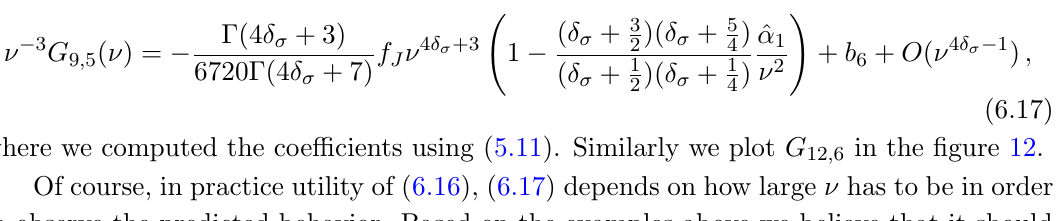
where d is given in (3.20). Notice that due to (cid:1) J comes from the unit operator as